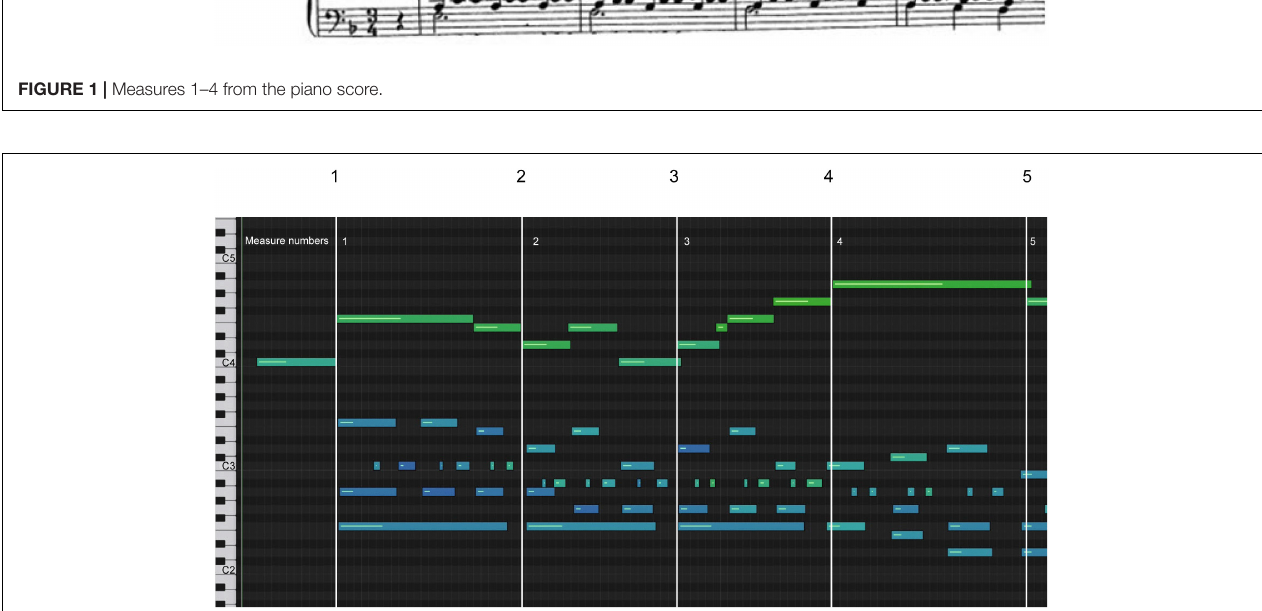
FIGURE 2 | Sonification graph of measures